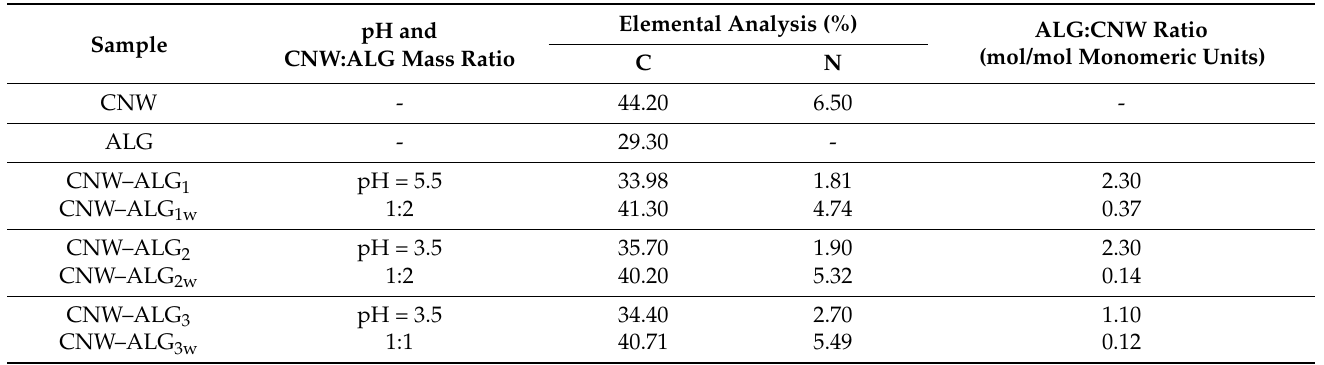
Table 1. Preparation conditions and composition of CNW–ALG PECs.